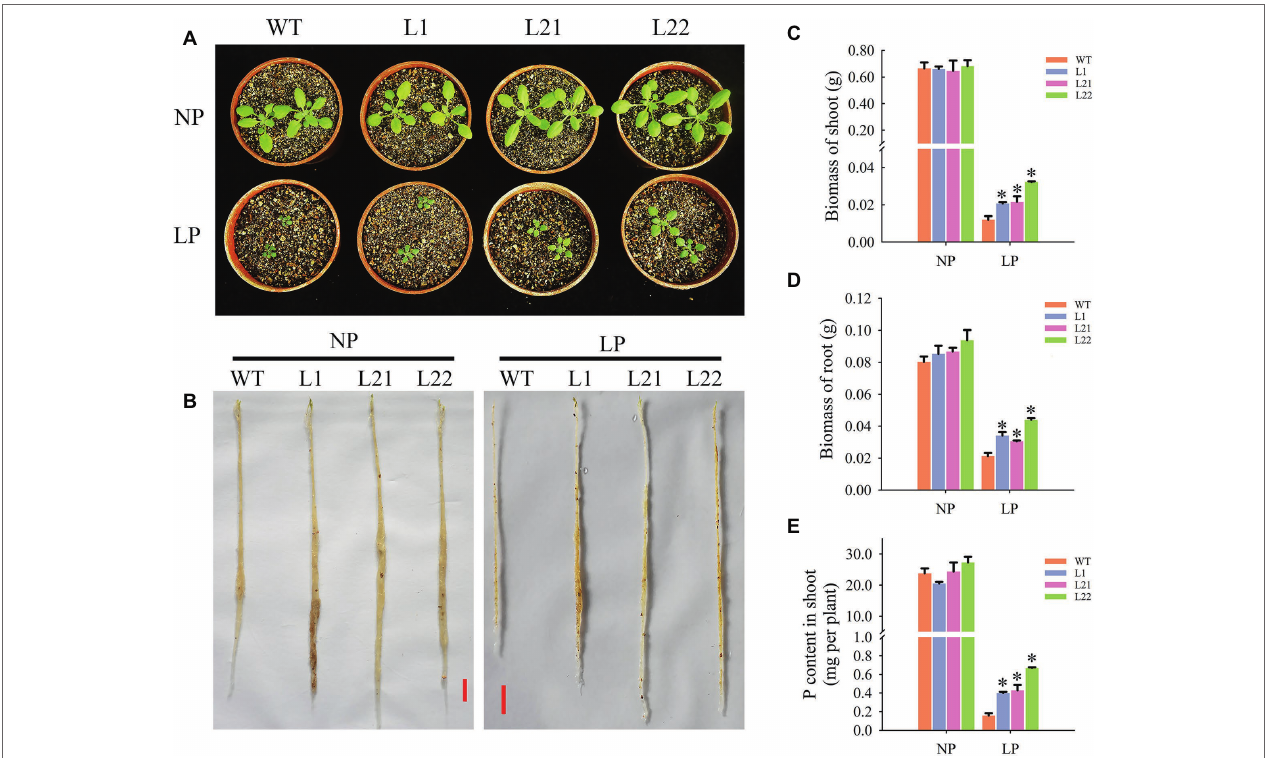
FIGURE 9 | Measurements of P acquisition efficiency in transgenic plants under different phosphorus conditions. (A) Phenotypic observation of shoots under NP and LP conditions. (B) Phenotypic observation of roots under NP and LP conditions. The scale bar = 1 cm. (C) Biomass of shoots measured in transgenic and wild-type (WT) plants under NP and LP conditions. The data are the mean ± SE ( n = 5). Error bars represent the SE. Asterisks indicate that the values are significantly different ( p < 0.05). (D) Biomass of roots measured in transgenic and wild-type (WT) plants under NP and LP conditions. The data are the mean ± SE ( n = 5). Error bars represent the SE. Asterisks indicate that the values are significantly different ( p < 0.05). (E) P content of shoots measured in transgenic and wild- type (WT) plants under NP and LP conditions. The data are the mean ± SE ( n = 5). Error bars represent the SE. Asterisks indicate that the values are significantly different ( p <